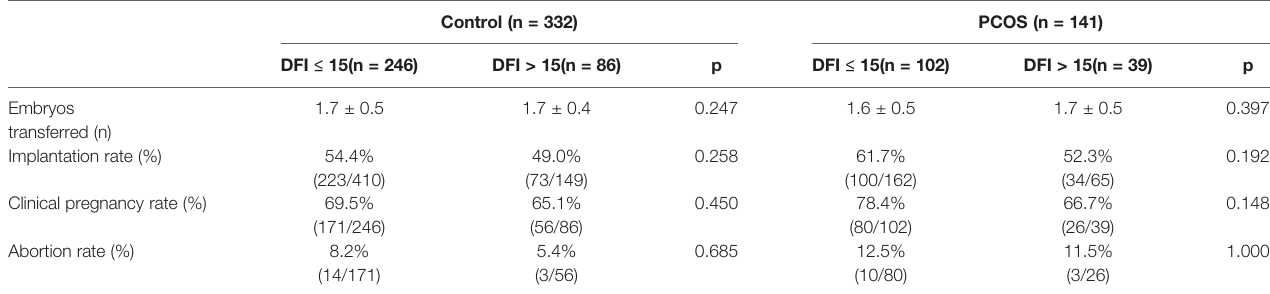
TABLE 3 | IVF-ET pregnancy outcomes in control and PCOS patients with different sperm